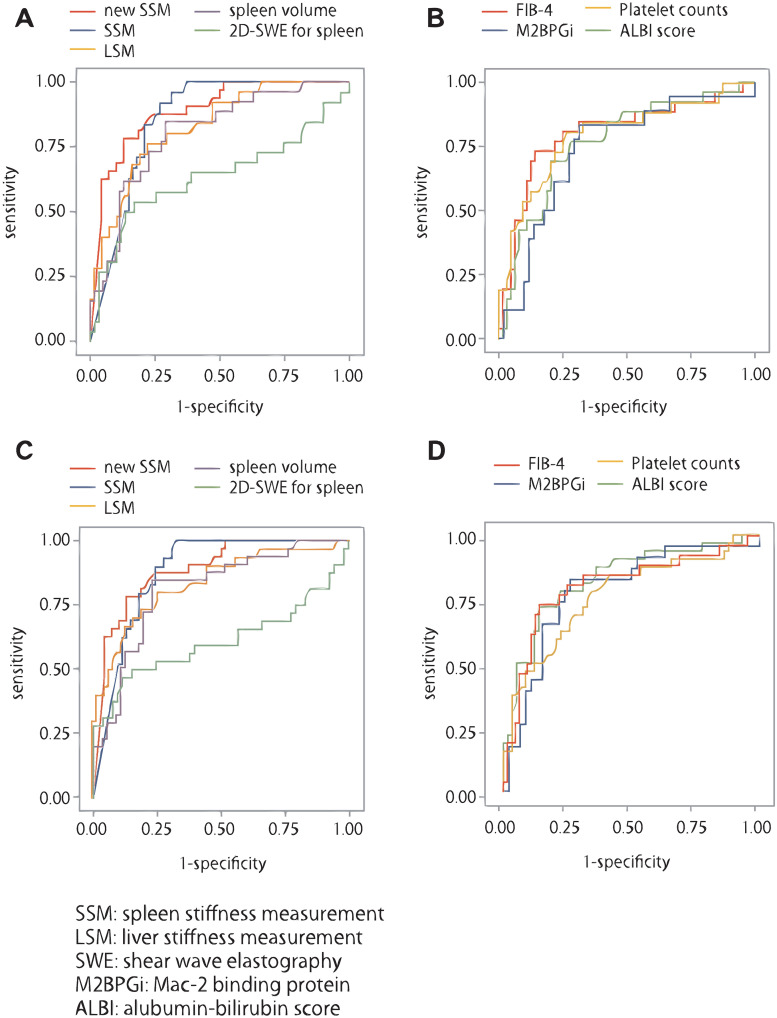
Diagnostic accuracy for predicting EGVs and complications of portal hypertension in the training set.A) ROC curves for the diagnostic accuracy for predicting EGVs by imaging. B) ROC curves for the diagnostic accuracy for predicting EGVs by biochemical markers. C) ROC curves for the diagnostic accuracy for predicting complications of PH by imaging. D) ROC curves for the diagnostic accuracy for predicting complications of portal hypertension by biochemical markers. SSM = spleen stiffness measurement, LSM = liver stiffness measurement, SWE = shear wave elastography, M2BPGi = Mac-2 binding protein, ALBI = albumin-bilirubin score, ROC = receiver operating characteristic, EGVs = esophagogastric varices, PH = portal hypertension.